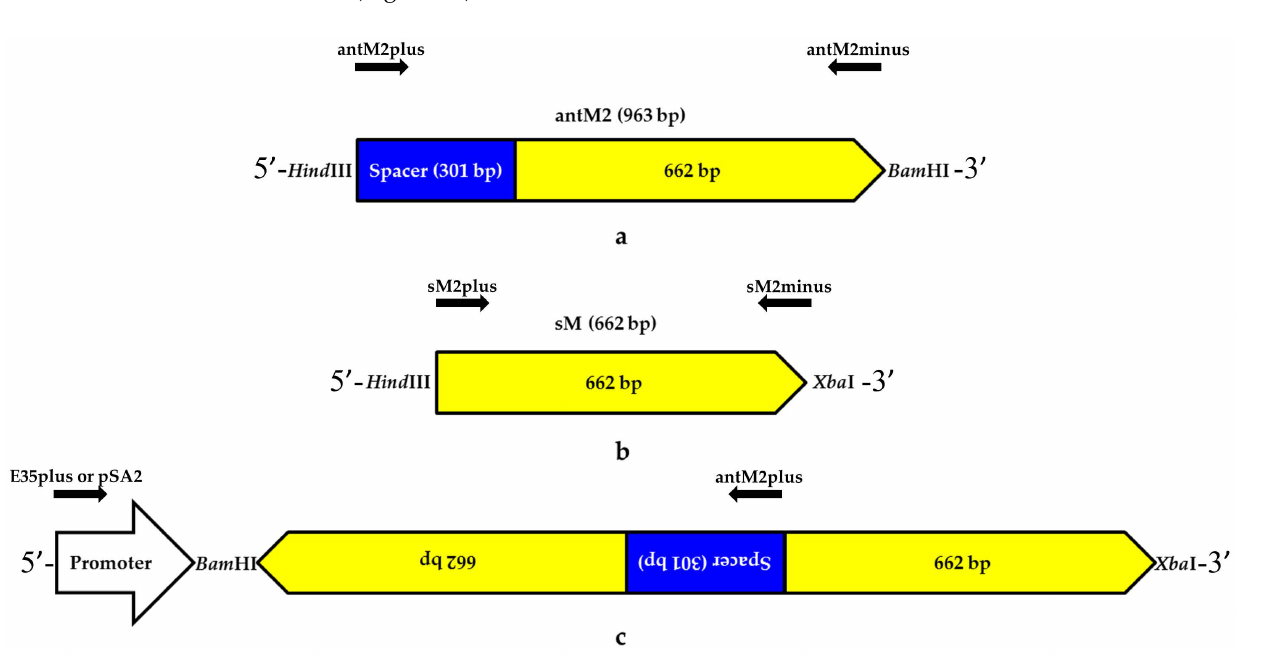
Figure 1. Genetic construct for the RNA interference targeting the MSH2 gene transcript of tomato plants. ( a ) Scheme of the antM2 nucleotide sequence (963 bp) including the spacer sequence (301 bp); ( b ) scheme of the sM2 nucleotide sequence (662 bp) complementary to 662 bp in the antM2 sequence; ( c ) relative positions of the antM2 and sM2 nucleotide sequences and the gene promoter for their transcription in plant cells. Positions of the primers used for cloning and molecular analysis are shown with the black arrows; primer designations are specified above the